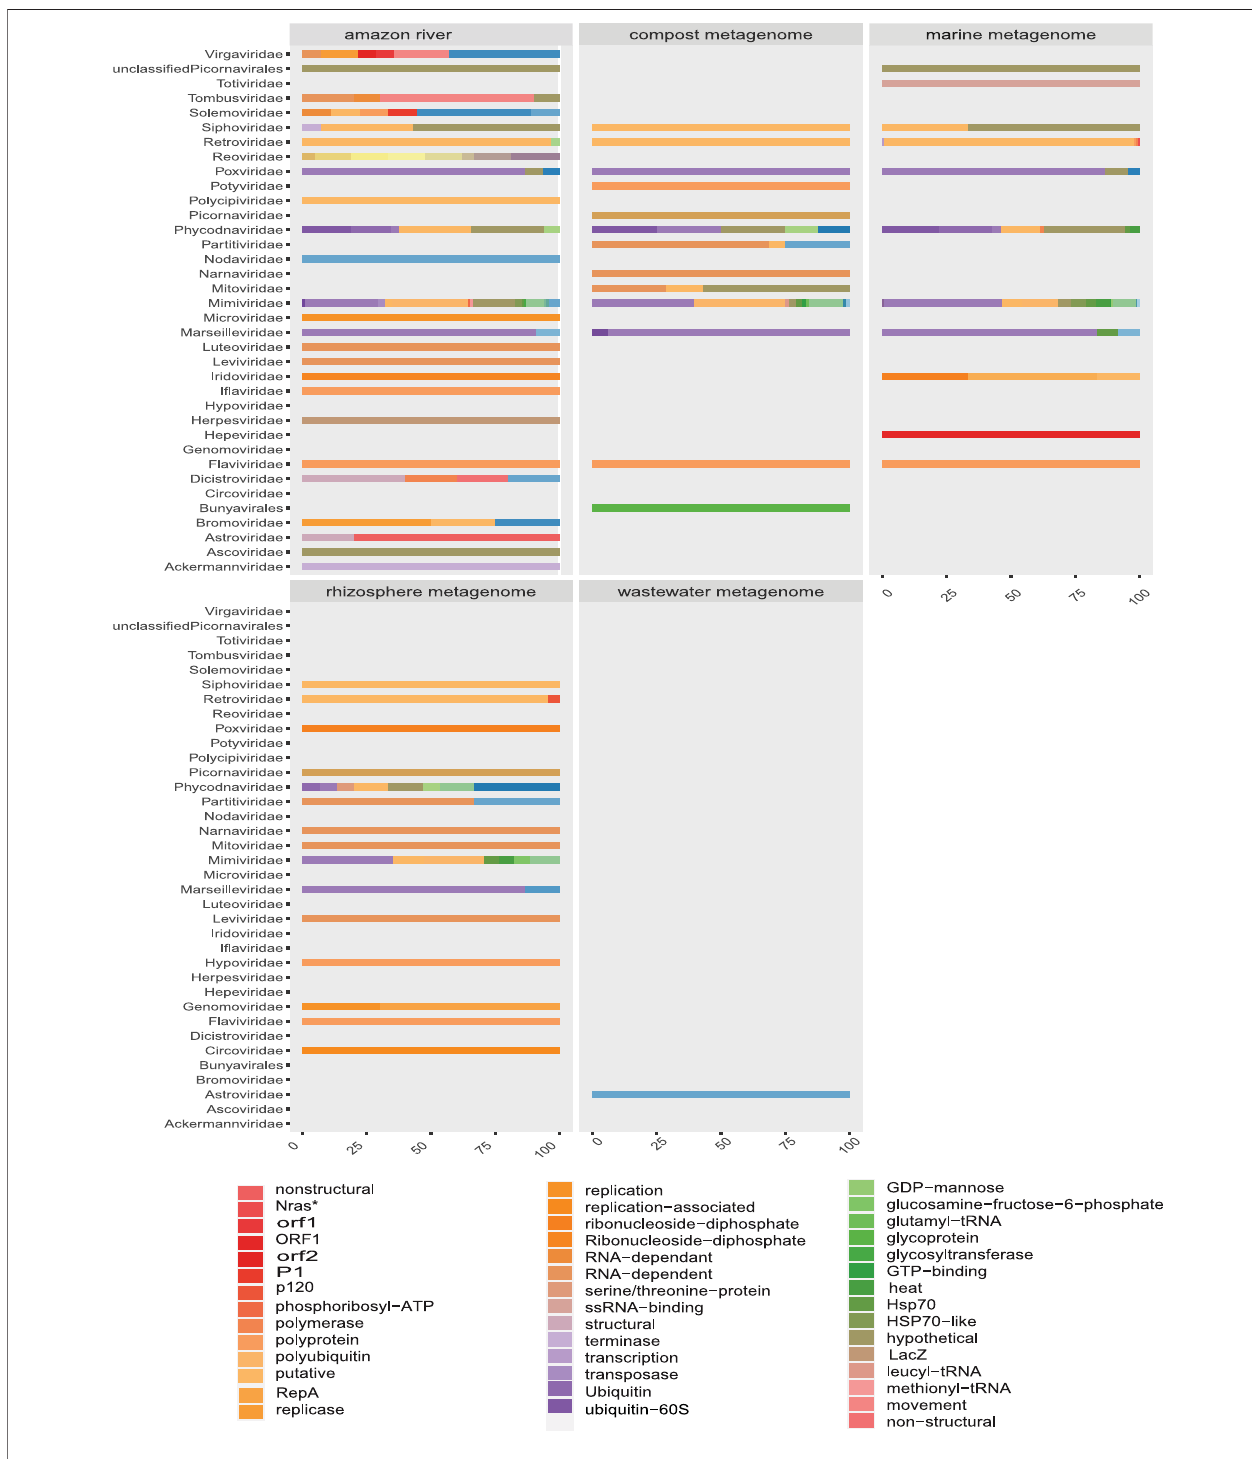
FIGURE 6 | Geographical distribution of the samples containing Arenavirus , Togavirus , and Flavivirus . The colored dots on the map symbolize the coordinates of each sampling group analyzed. The difference in size is proportional to the number of sequences of the family shown.